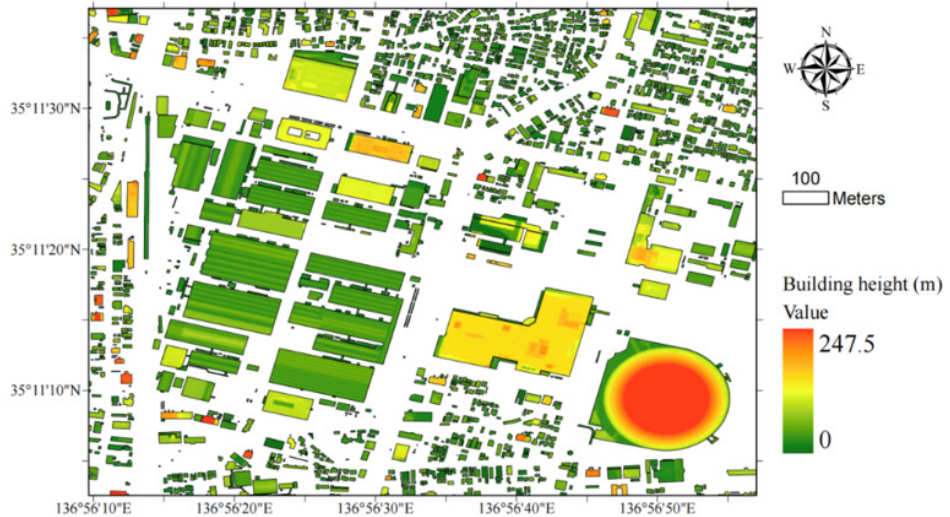
Figure 3. Building height data in a part of the target area (the value of building height is the average 2 after LiDAR data value in 1 m 2 after LiDAR data arrangement). value in 1 m